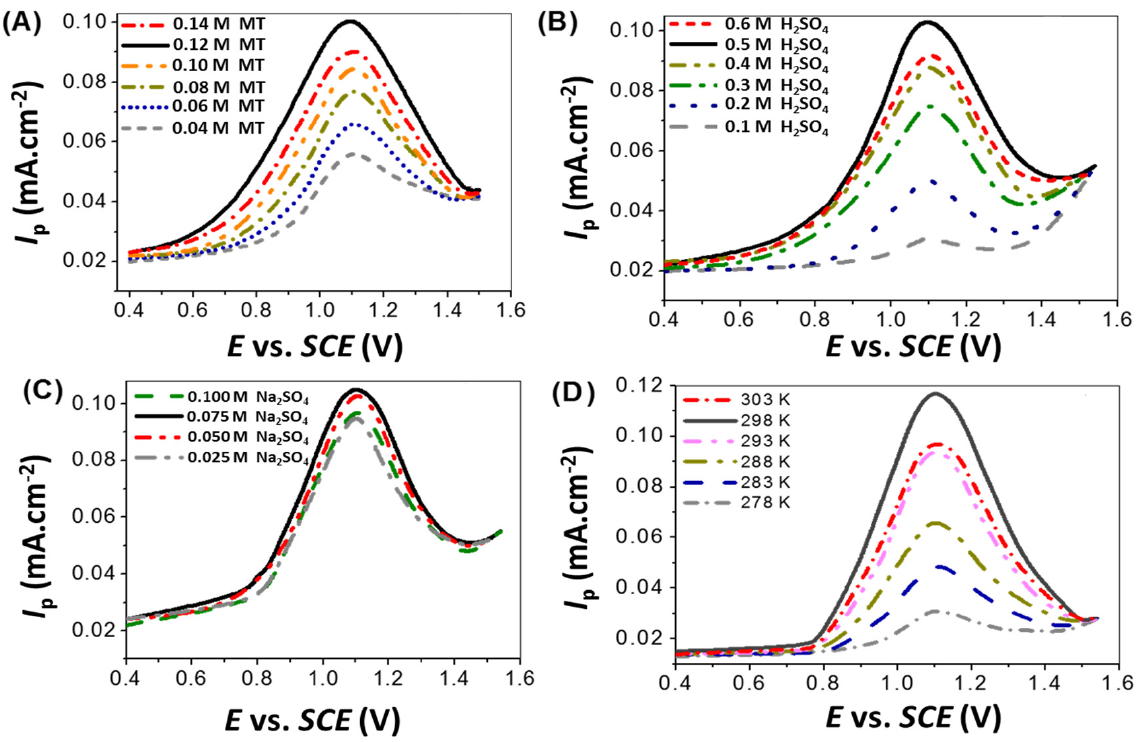
Figure 1. The effect of the concentrations of ( A ) m-toluidine (0.04 to 0.14 M), ( B ) H 2 SO 4 (0.1 to 0.6 M), ( C ) Na 2 SO 4 (0.025 to 0.1 M), and ( D ) temperature (278 to 303 K) on the elctropolymerization of m-toluidine.